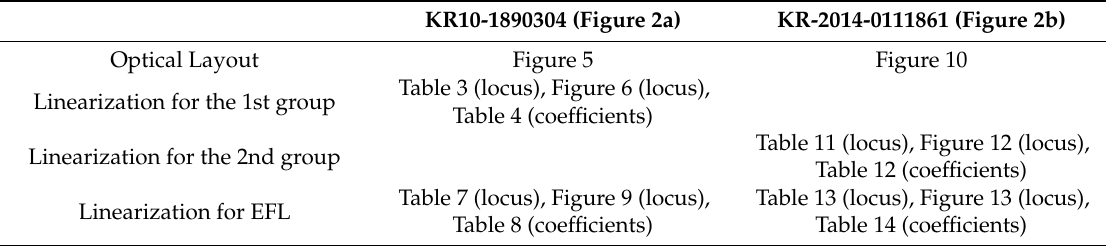
Table 1. Summary of examples of optical systems and locus calculation results used in this paper.